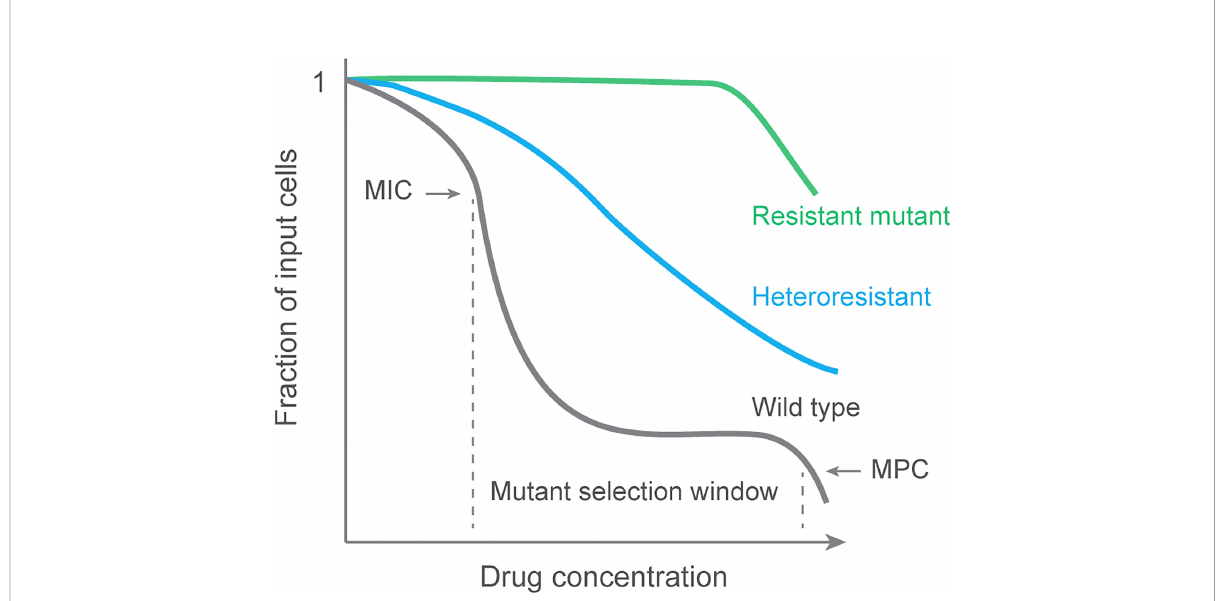
FIGURE 1 Population analysis pro fi le and mutant selection window. Data are generated by applying a bacterial culture to a series of agar plates containing various concentrations of antimicrobial. After incubation to allow colony formation, colonies are counted, and the number is plotted for each drug concentration as a fraction of the input. Resistant cultures are unaffected by the drug until concentrations are very high. A fully susceptible culture (wild type) exhibits a sharp drop in colony recovery at MIC. A second sharp drop occurs at the MIC of the least susceptible mutant subpopulation (MPC). Selective enrichment of resistant mutants occurs at concentrations between MIC and MPC, a range called the mutant selection window (Zhao and Drlica, 2001). A population containing a mixture of susceptible and resistant subpopulations is called heteroresistant. Data for wild-type M. tuberculosis can be found in reference (Zhou et al.,